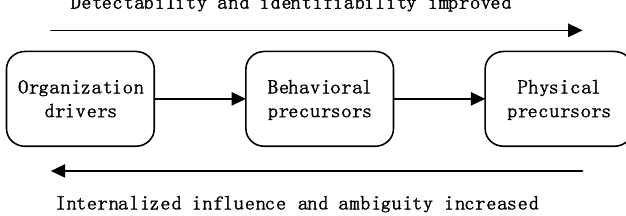
Figure 6. Diagram of changes in the three types of precursors.